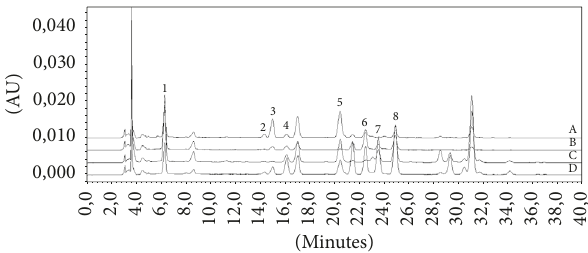
Figure 4: Chromatograms of the investigated pear sample extracts, 𝜆 = 360 nm. The uppercase letters denote different pear cultivars: A: “Patten”; B: “Conference”; C: “Grabova”; and D: “Concorde.” Numbers indicate the peaks of analytes: 1: chlorogenic acid; 2: quercetin-3- O -rutinoside (rutin); 3: quercetin-3- O -galactoside (hyperoside); 4: quercetin-3- O -glucoside (isoquercitrin); 5: quercetin-3- O -malonylglucoside; 6: isorhamnetin rutinoside; 7: quercetin-3- O -rhamnoside (quercitrin); and 8: isorhamnetin